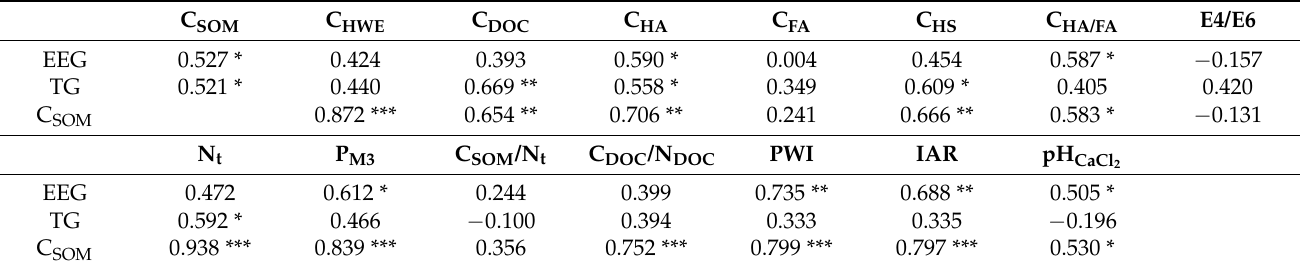
Table 6. Relationship between glomalin and other soil